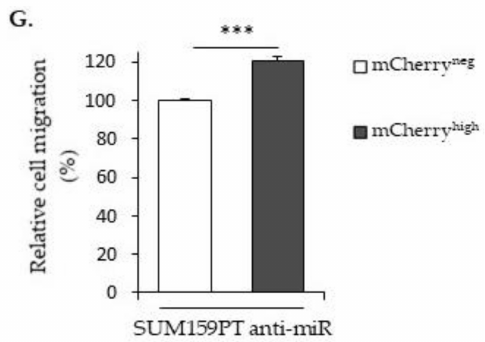
Figure 2. H19 and miR-675 both promote breast cancer cell migrations. ( A ) Control (mock) or H19 -stably overexpressing cells (H19) were cultured in Transwell for 24 h. Migrated cells were then incubated with 1-mM Hoescht 33258 and counted. ( B ) Migratory capacities of the control (siCtrl) and H19 -knockdown cells (siH19) determined by Transwell assay. ( C ) MDA-MB-231 control (mock) or miR-675-stably overexpressing cells (miR-675) were cultured in Transwell for 24 h. Migrated cells were then incubated with 1-mM Hoescht 33258 and counted. ( D ) Migratory capacities of miR-675-transfected cells (miR) or miR-675-specific inhibitor transfected cells (anti-miR) determined by Transwell assay. Results are presented as a percentage of the control. ( E ) Relative migratory capacities of SUM159PT-pH19-mCherry neg versus SUM159PT-pH19-mCherry high determined by Transwell assay. ( F ) Migratory capacities of miR-675-specific inhibitor transfected cells (anti-miR). Results are presented as a percentage of the control. ( G ) Migratory capacities of miR-675-specific inhibitor transfected cells (anti-miR). Results are presented as a percentage of the mCherry neg condition. * p < 0.05; ** p < 0.01; *** p < 0.001; ns: not